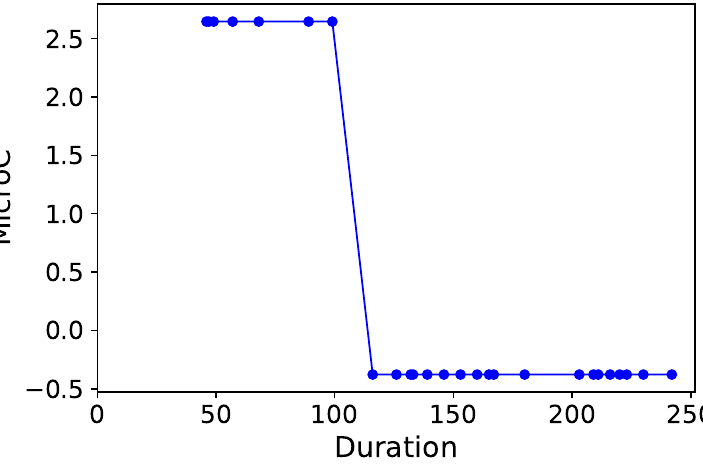
Figure A13. Normalized categorical carbon source (MicroC) for Reactor 1.